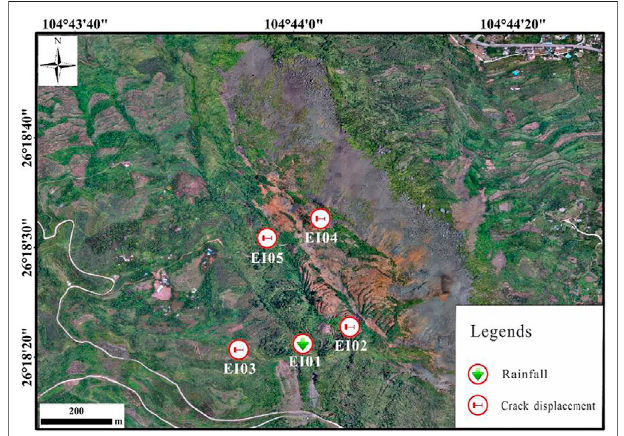
FIGURE 12 | Schematic diagram of monitoring equipment deployment.